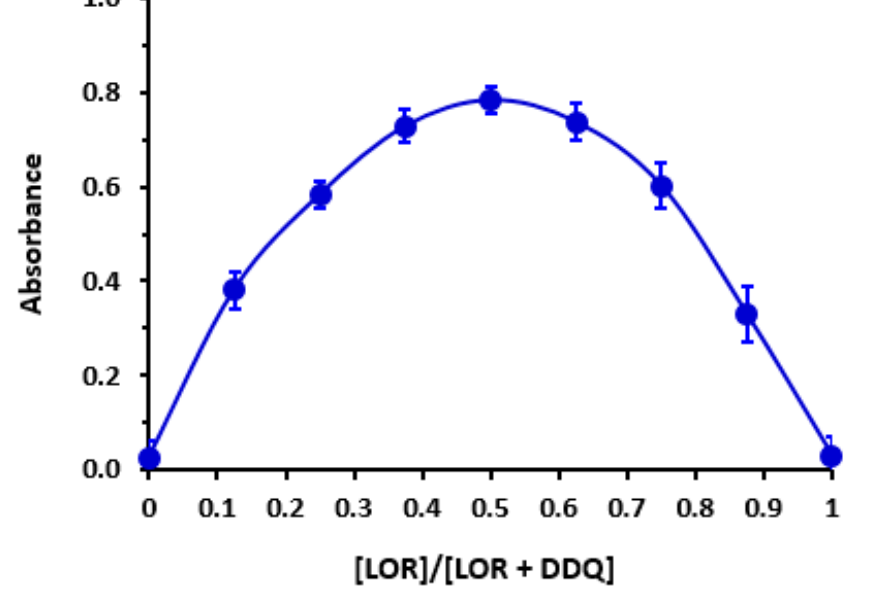
Figure 4. Job’s continuous variation plot for molar ratio determination of CT reaction of LOR with DDQ. Table 3. Atom numbers, types, and their calculated charges on the energy minimized LOR molecule.